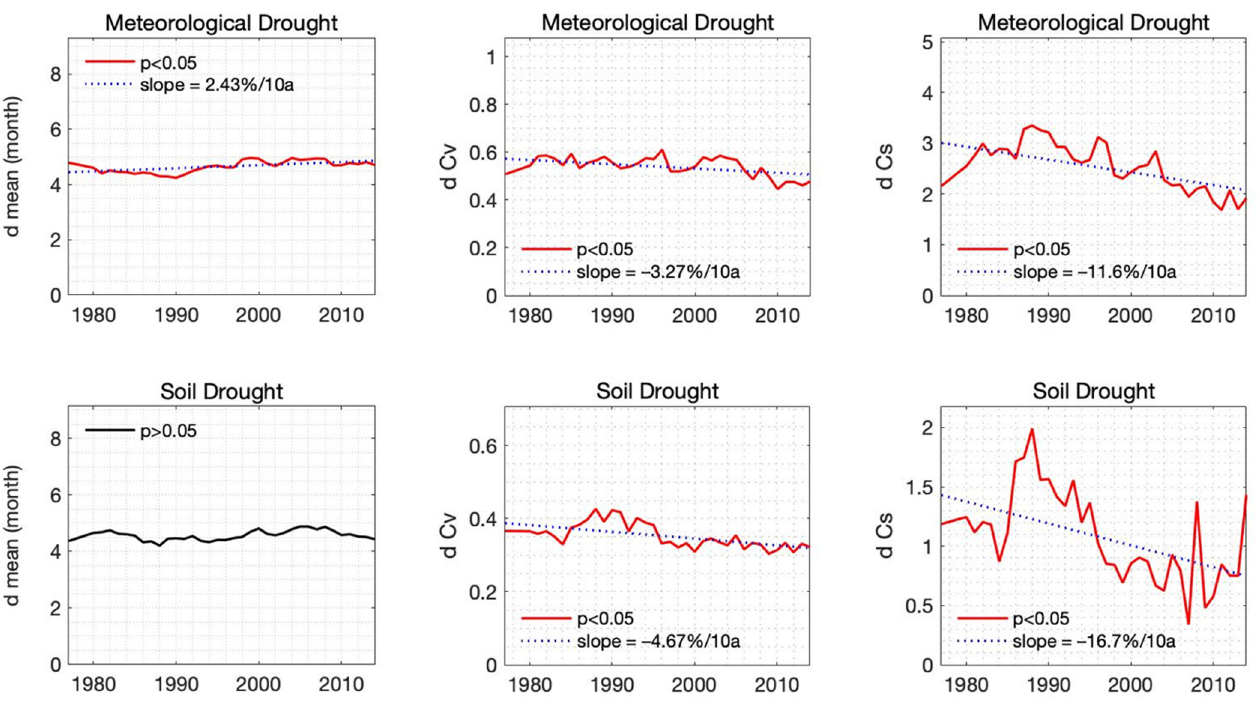
Figure 6. The change in the drought duration distribution. d refers to the continuous estimate of drought duration as Equation (1).